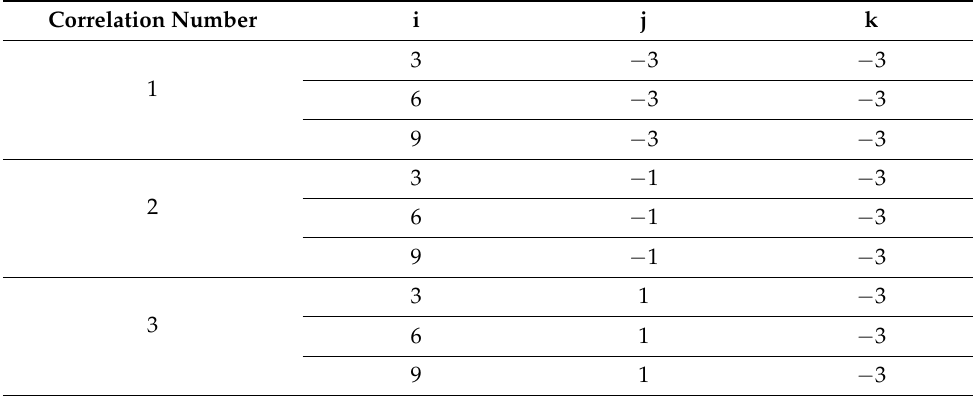
Table A1. List of spectral components used for inner race